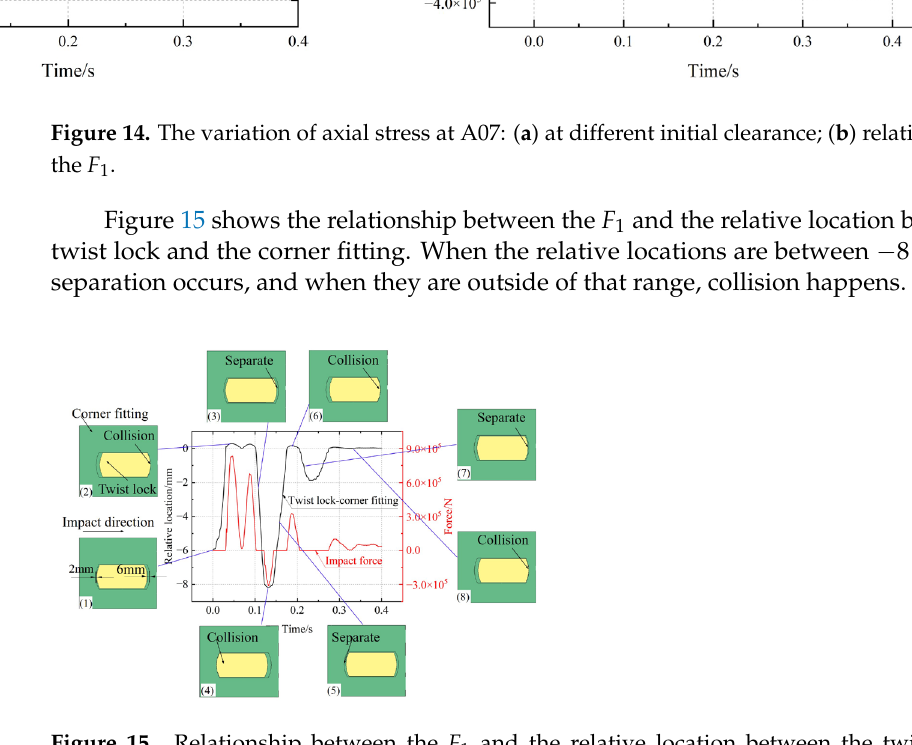
Figure 15. Relationship between the F 1 and the relative location between the twist lock and corner fittings.